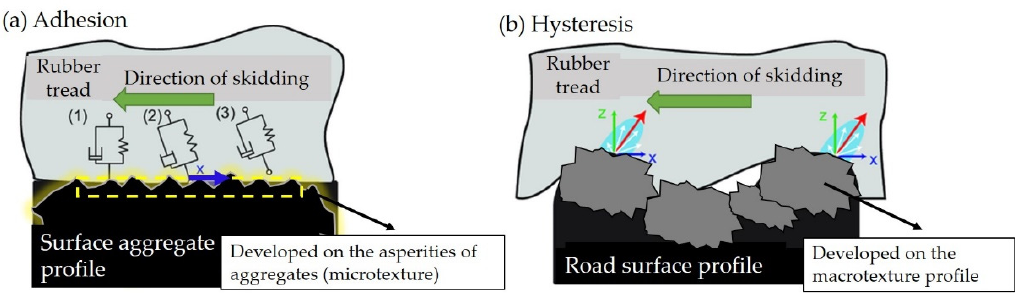
Figure 5. Illustration of ( a ) adhesion mechanism and ( b ) hysteresis mechanism (adapted from [45]).